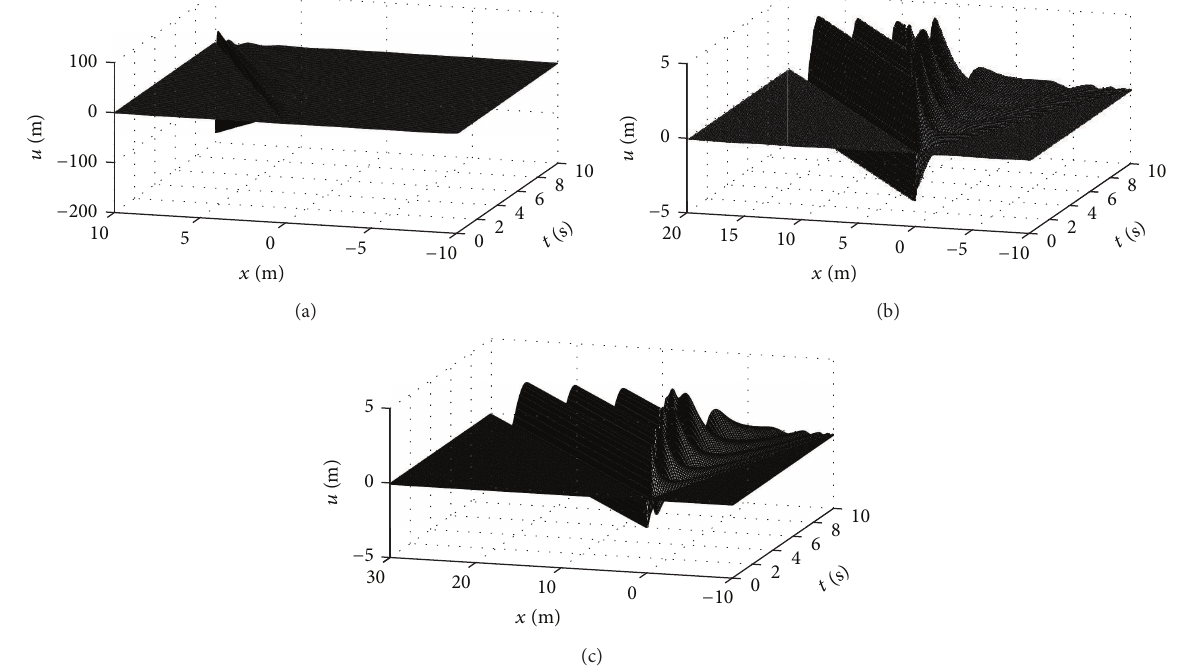
Figure 10: The displacement of the string when the mass moves at sonic or supersonic velocities (a) 𝑉 = 1 ; (b) 𝑉 = 2 ; and (c) 𝑉 = 3 .